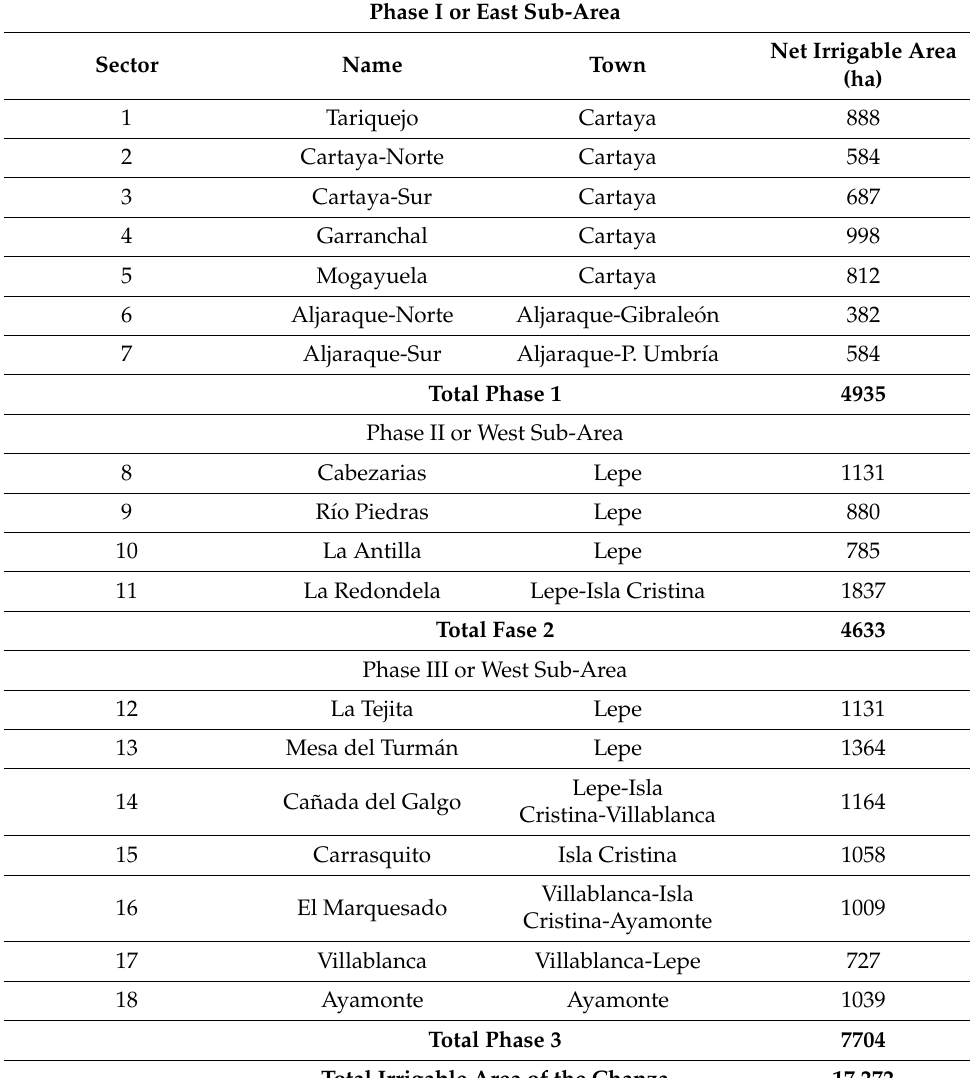
Table 4. Phases, sub-areas and sectors of the Chanza irrigable